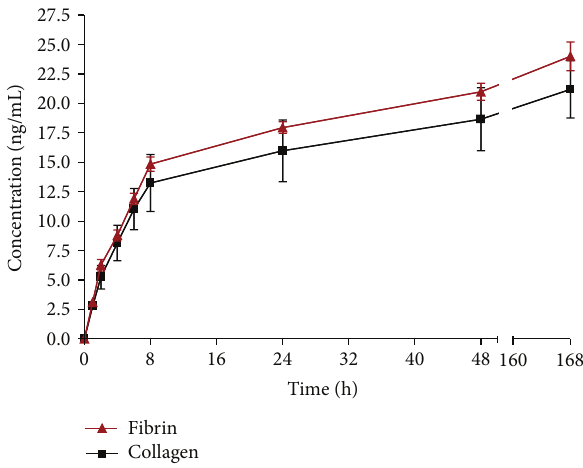
Figure 2: HGF (ng/mL) released from fibrin and collagen gels over time. 75 ng/mL HGF was incorporated into collagen and fibrin gels. Supernatant was used for ELISA and gels without HGF served as control. 𝑛 = 2